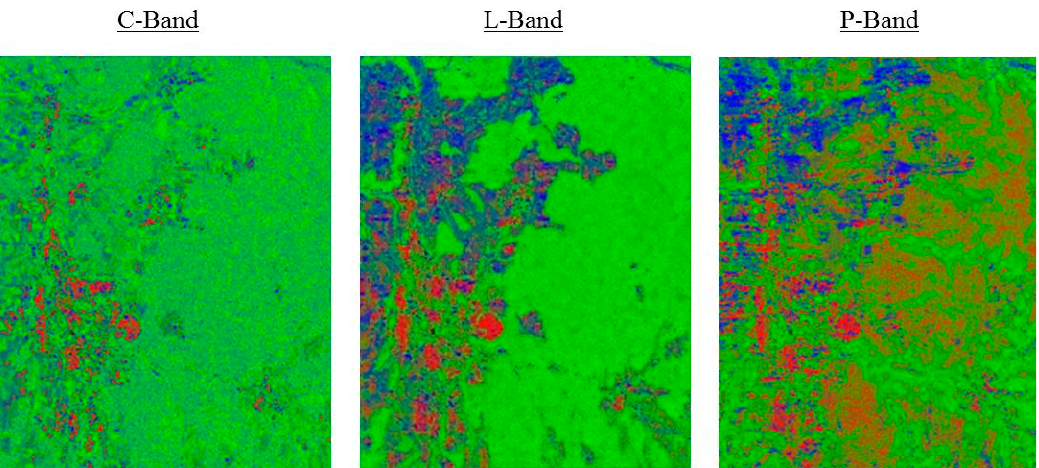
Figure 7. Results of the ANNED algorithm applied to three different wavelength images in Freiburg obtained by AIRSAR. Green, red and blue are assigned to the volume, double bounce and ground components [21].